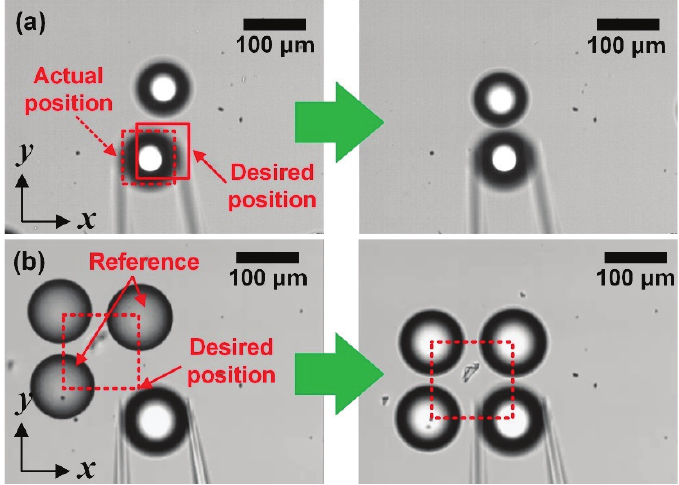
Figure 11. Error recovery to compensate the position error based on a prearranged object. ( a ) Manipulating the second object by adjusting X (cid:556) axis; ( b ) Manipulating the fourth object by adjusting X and Y (cid:556) axis.